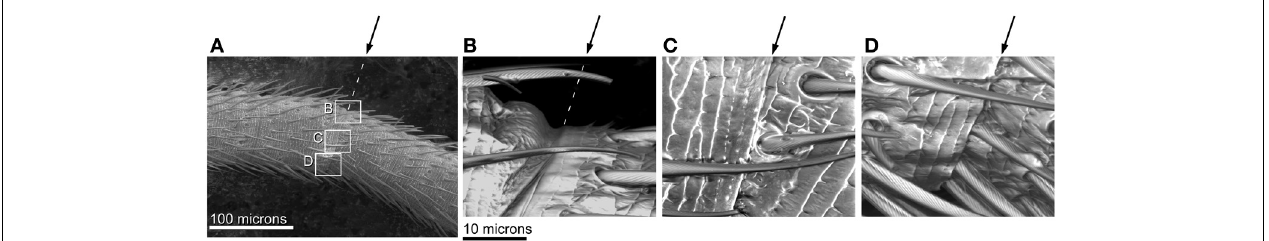
FIGURE 9 | SEM images of joints in bending antenna. Arrows indicate joint. (A) A bent flagellum from an adult male. Rectangles denote parts of joint shown in higher magnification in (B–D) . (B) Closer view of joint on convex side of bent flagellum (in tension) showing slight unfolding at joint.